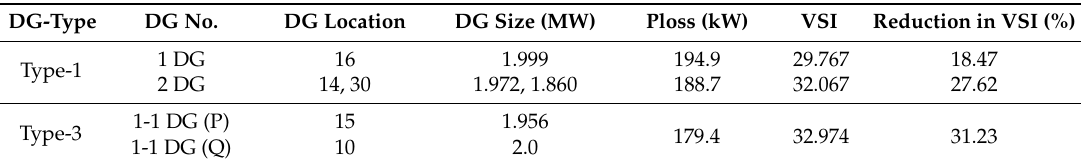
Table 4. Optimal placement and sizing of DG for case-1 as single-objective function with priority to 2nd objective function.